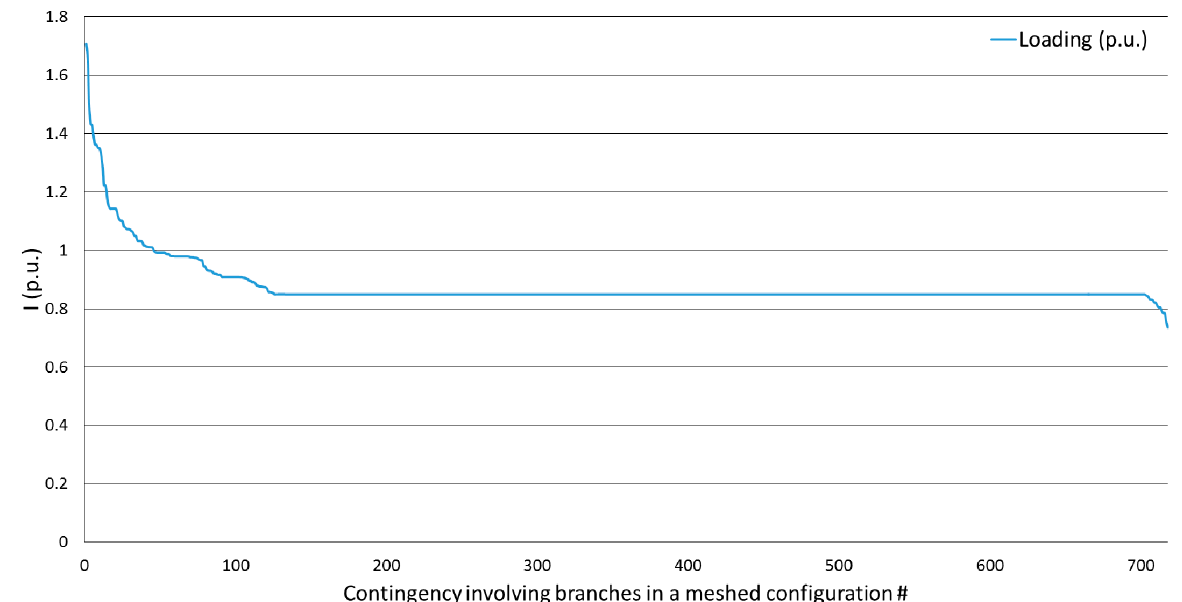
Figure 9. Maximum loadings (in p.u. of the branch capacity) due to contingencies involving branches located in meshed portions of the PDN.